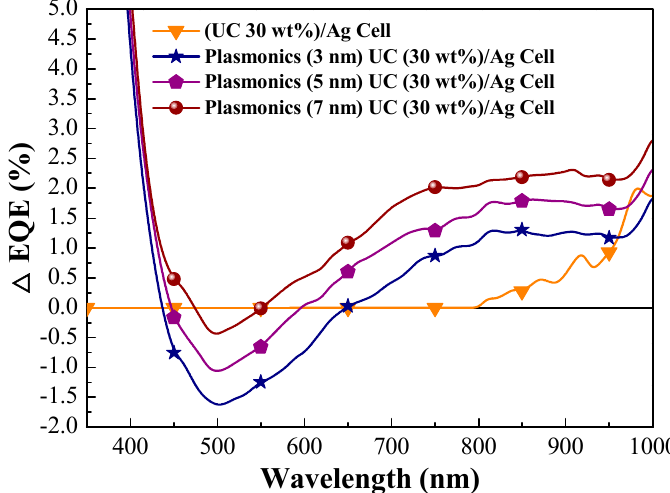
Figure 15. EQE enhancement of UC (30 wt%) / Ag cell and plasmonic UC (30 wt%) / Ag cell with In NPs (3 nm, 5 nm, 7 nm) respectively compared with the reference cell. Energies 2019 , 12 , x FOR PEER REVIEW